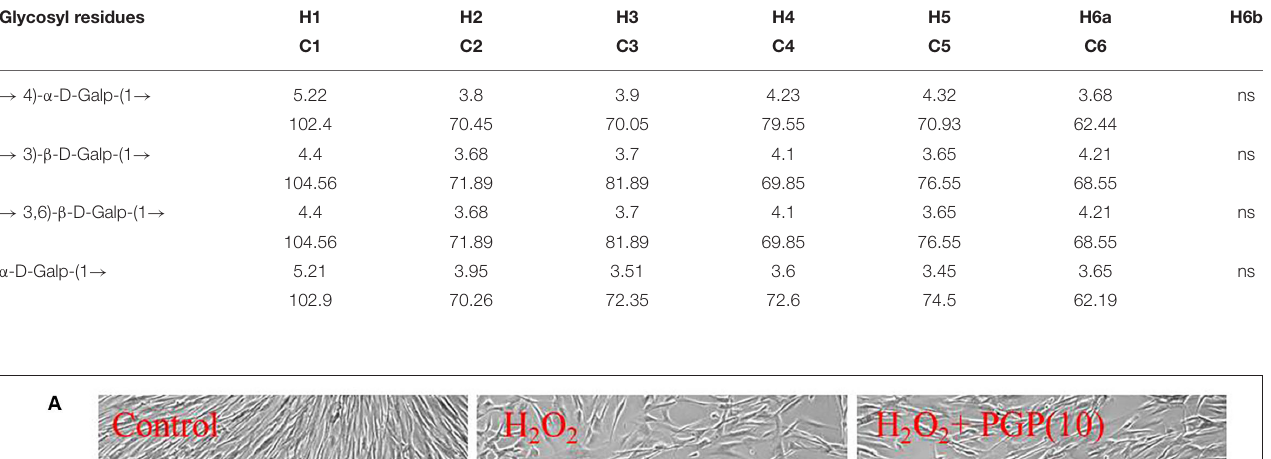
TABLE 2 | Glycosidic bond signal attribution of PGP.